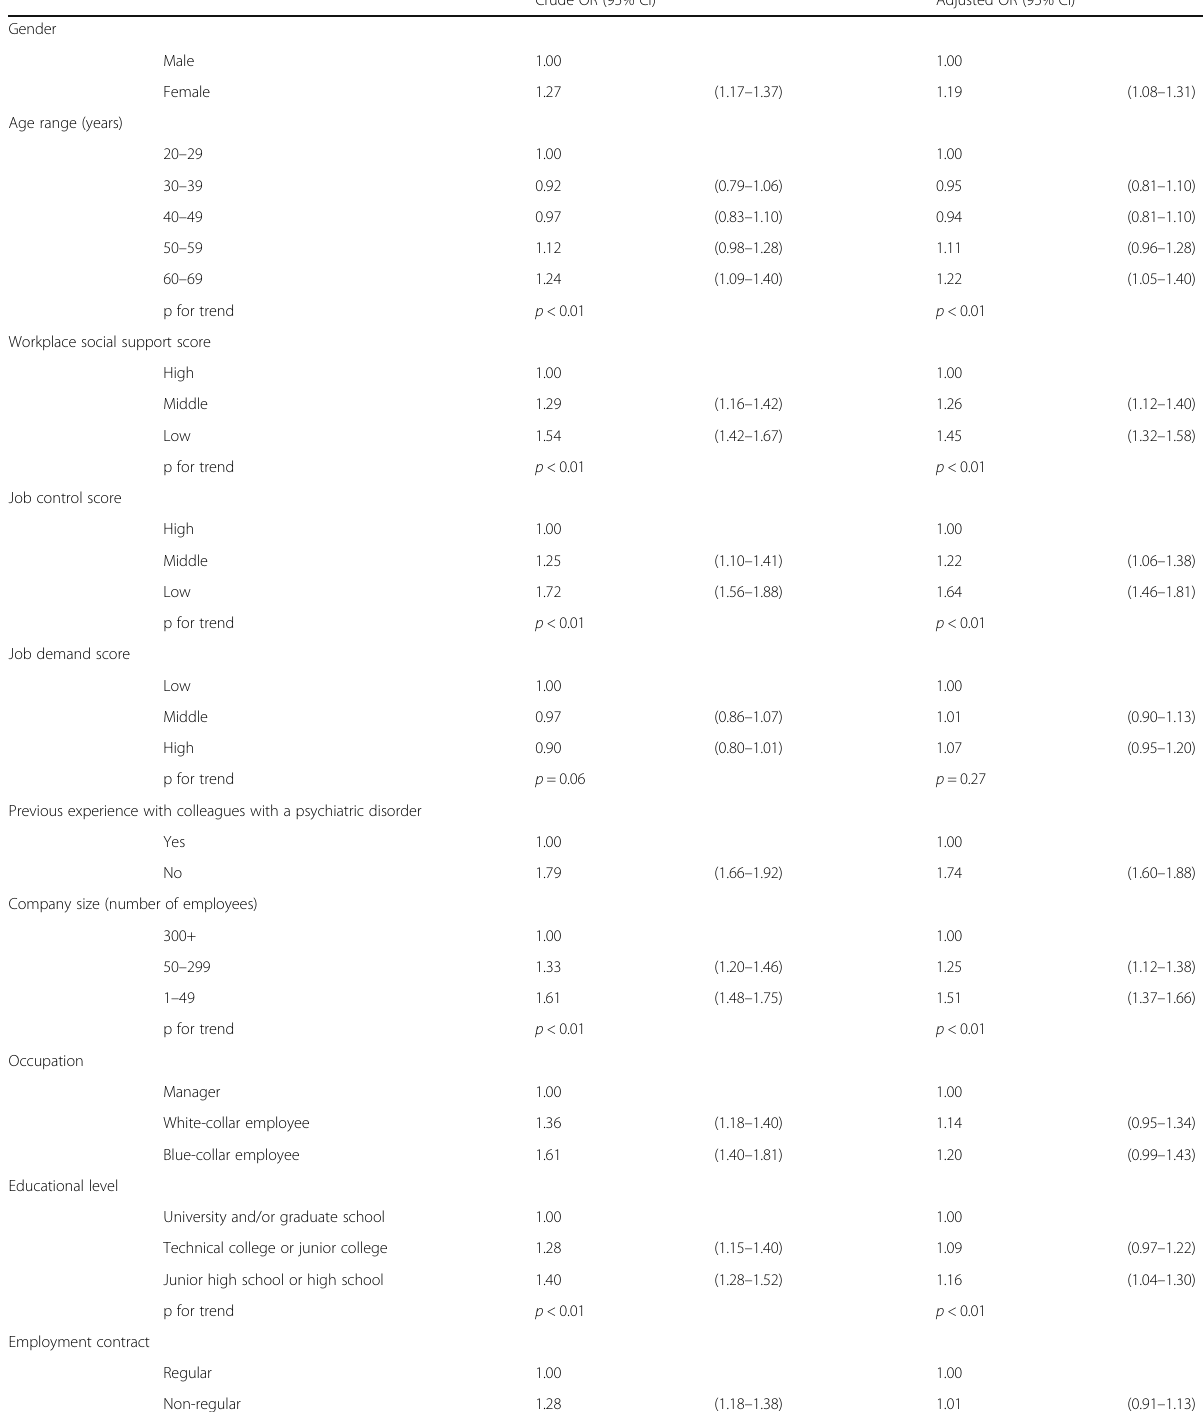
Table 3 Multiple logistic regression analysis of associations between psychosocial factors and colleagues ’ negative perception ( n